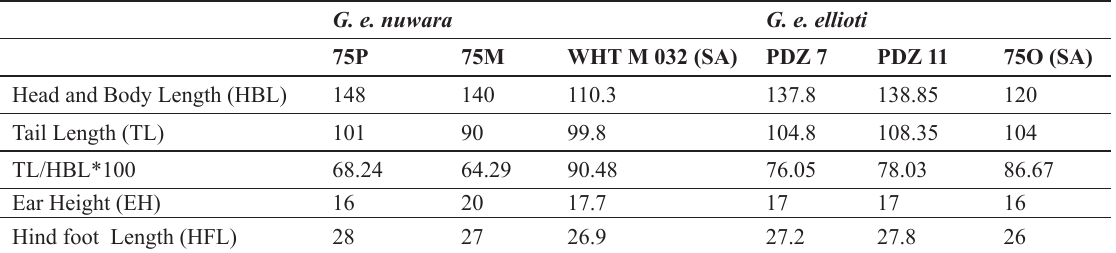
Table 3: External measurements (mm) of Golunda ellioti nuwara , and G. e. ellioti . (SA- Sub Adult)